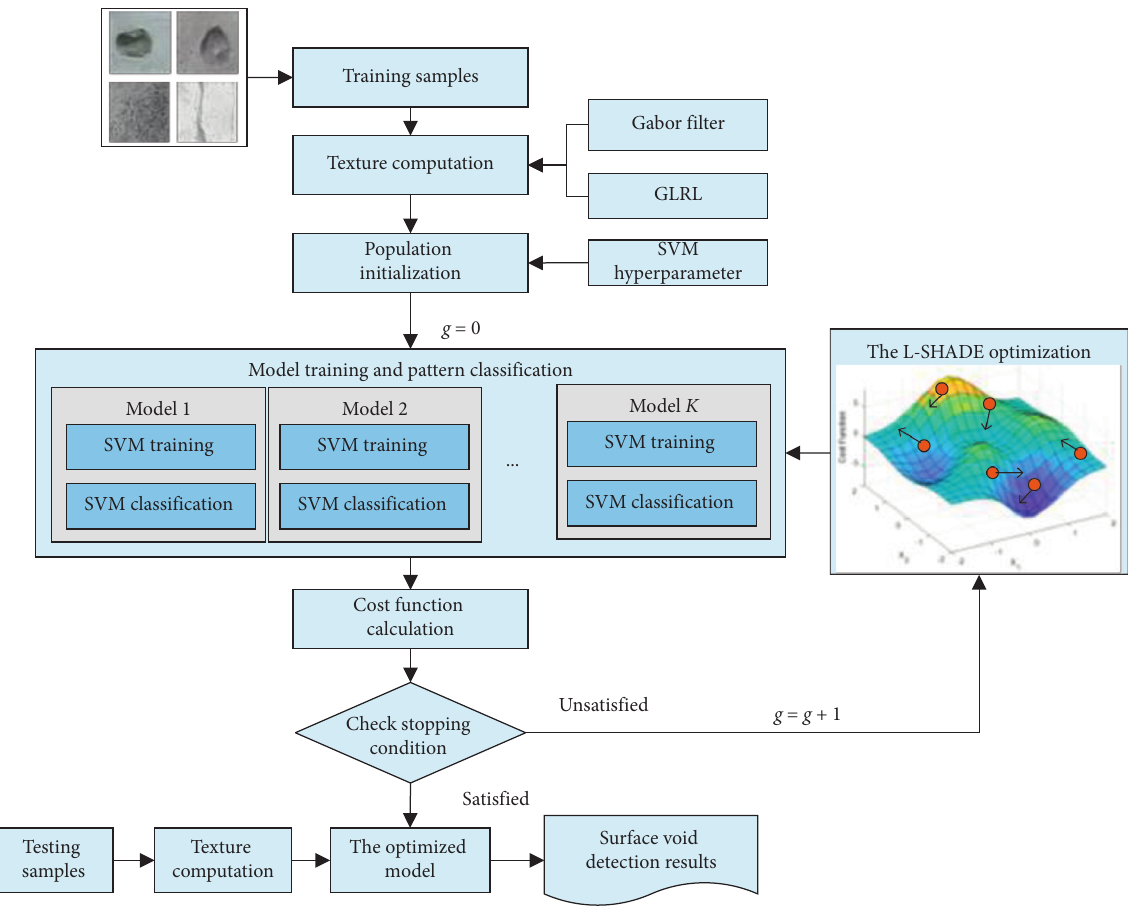
Figure 5: The proposed L-SHADE-SVM-SVD used for automatic detection of concrete surface